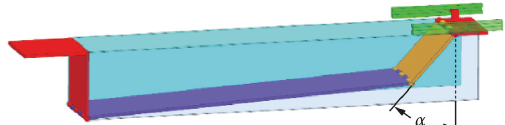
Figure 2: A deformed situation of the cavity with the slant angle α of the trailing wall 6.